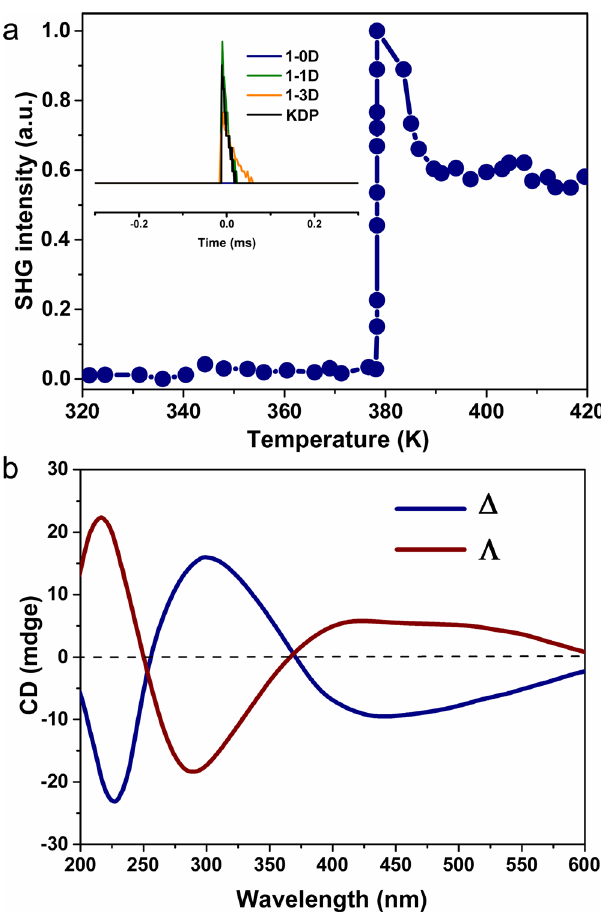
Fig. 3 The centric-to-acentric symmetric variation involved in the two- step structural transformation. a The temperature-dependence of SHG upon heating the crystal of 1-0D to 420 K. Inset: comparison of the SHG signal with KDP. b The CD spectra of 1-1D with enantiomeric structures.